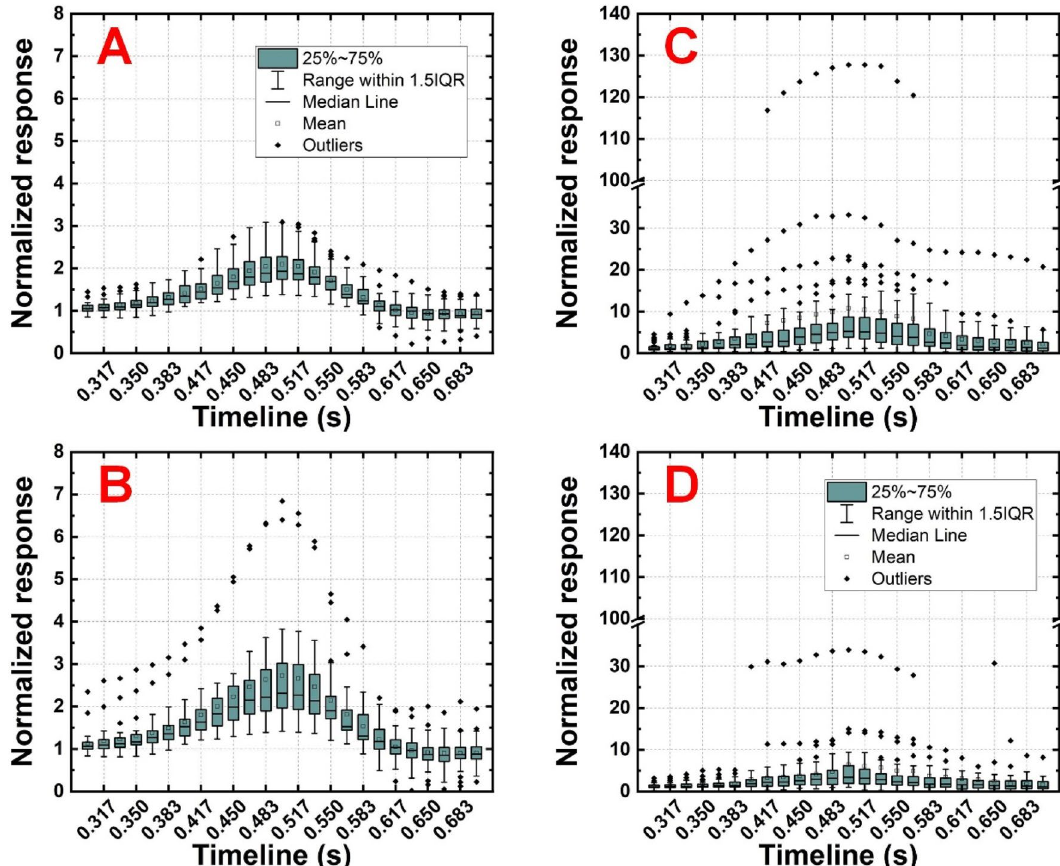
Figure 4. Statistical 67 normalized capacitive responses on the ( A ) first and ( B ) second segments of the index finger of the professional player. Statistical 39 normalized capacitive responses on the ( C ) first and ( D ) second segments of the index finger of the amateur player. All panels share identical statistical definitions and IQR represents interquartile range. Note that the response ranges in ( C ) and ( D ) are different from those in ( A ) and ( B ), and breaks are applied to ( C ) and ( D